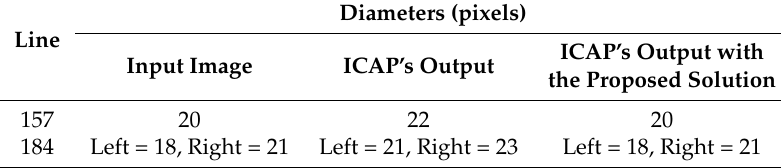
Figure 10. One-dimensional cross sections of the train’s headlights. Table 2. Diameter of one-dimensional cross sections of the train’s